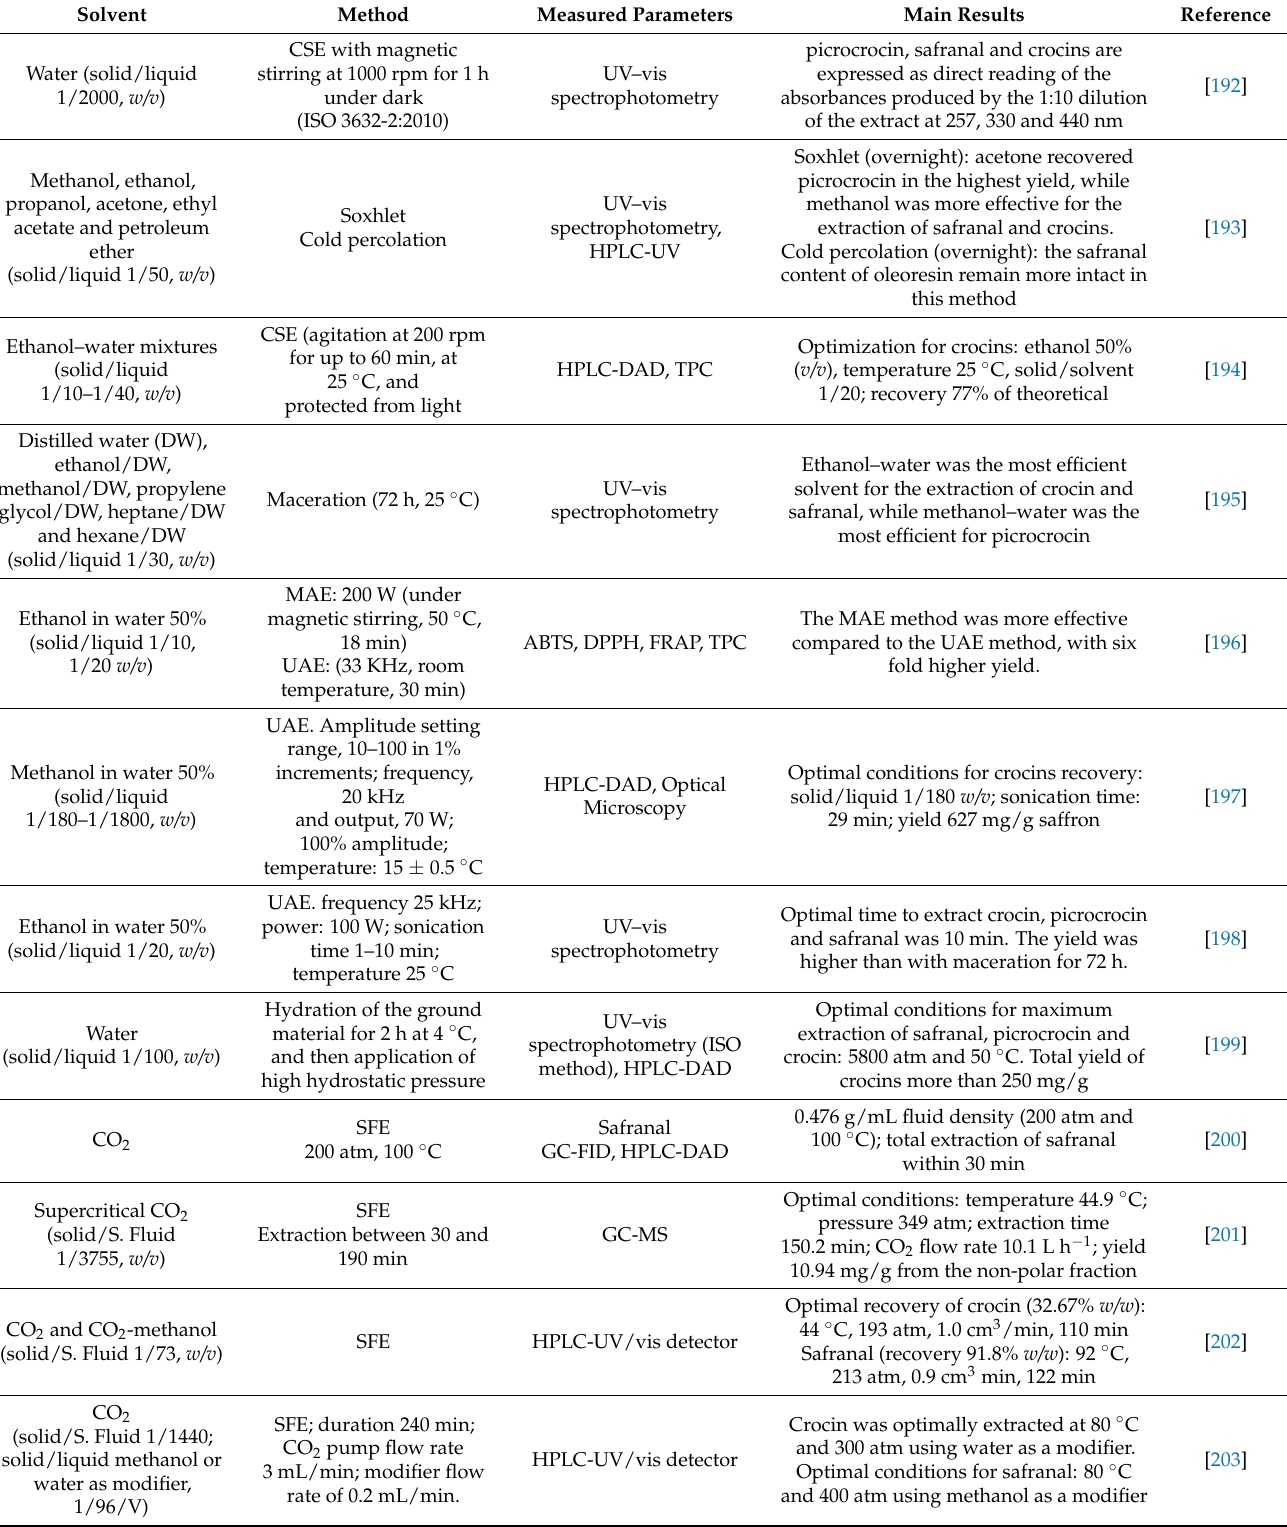
Table 7. The extraction parameters of Crocus sativus stigmas, as recorder from the extensive review of